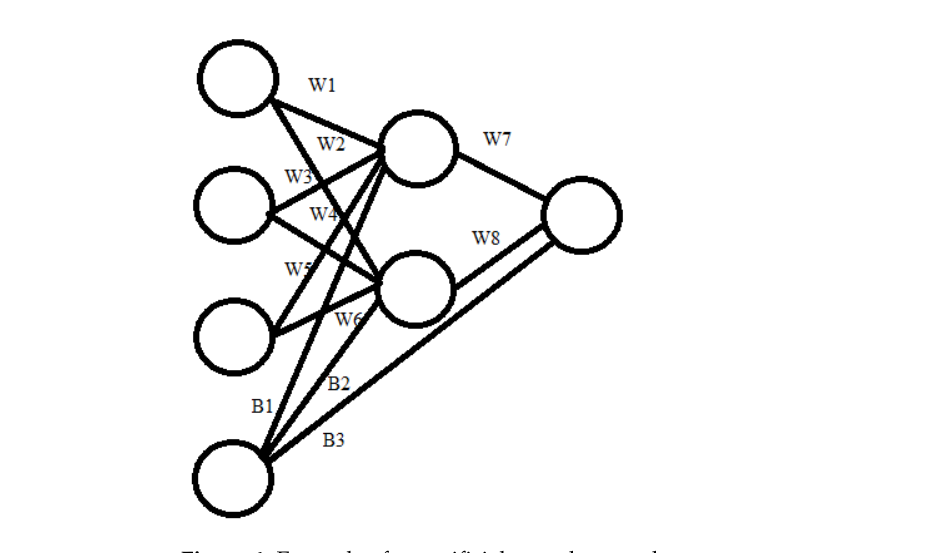
Figure 4. Example of an artificial neural network. Based on the representation (16) and Figure 4, the model of an artificial neural network based on a Petri net can be represented as follows (see Figure 5).